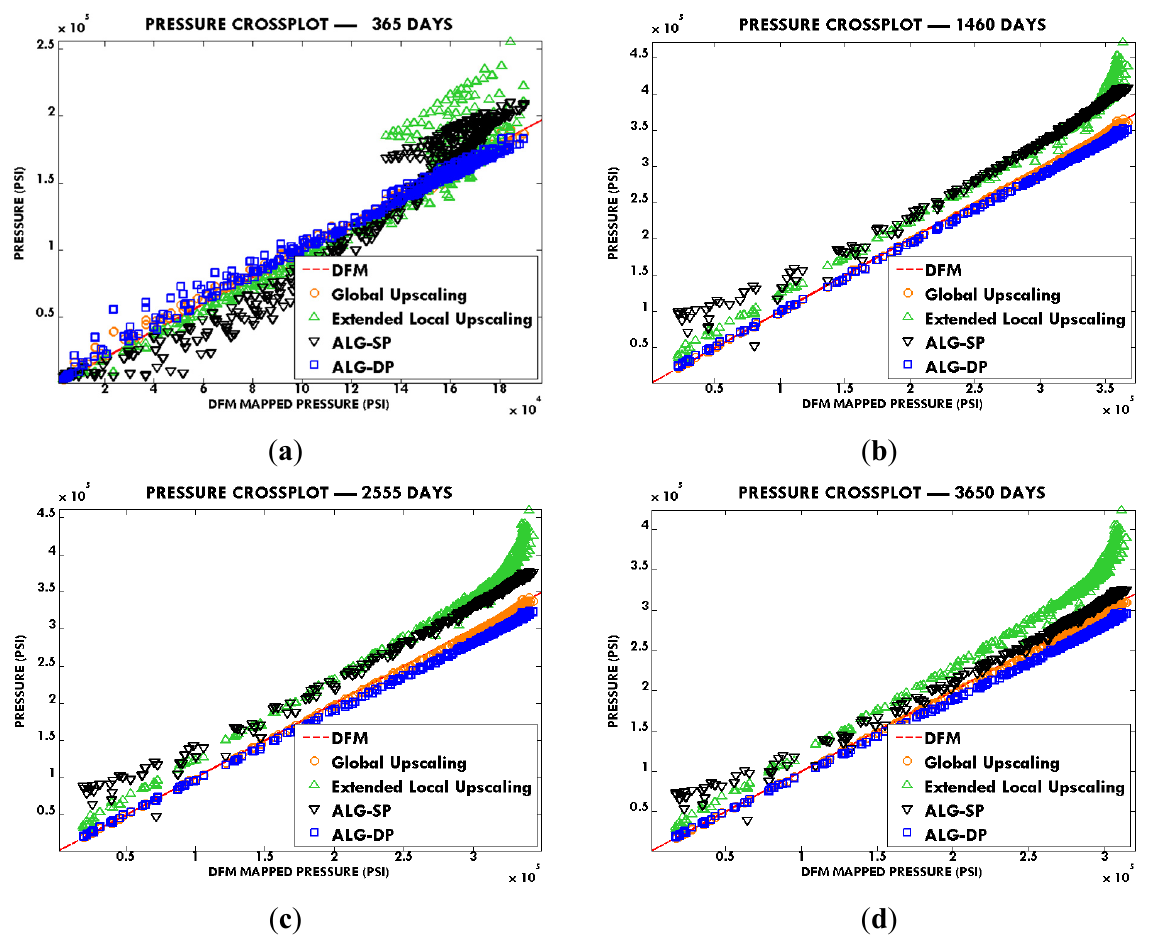
Figure 13. Pressure cross plot for case 2 at ( a ) 365 days; ( b ) 1460 days; ( c ) 2555 days; ( d ) 3650 days.